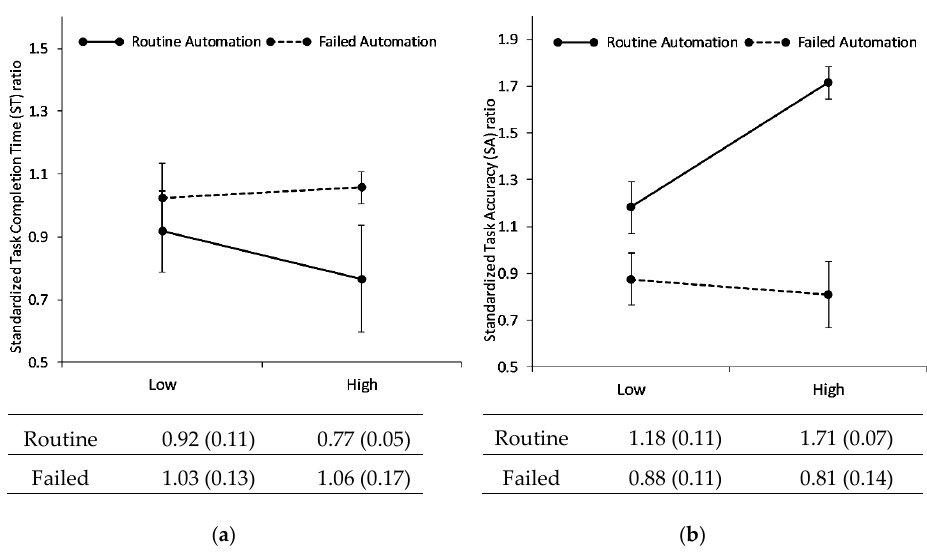
Figure 2. ( a ) Standardized task completion time (ST) ratios of four degrees of automation. ( b ) Standardized task completion accuracy (SA) ratios of four degrees of automation.